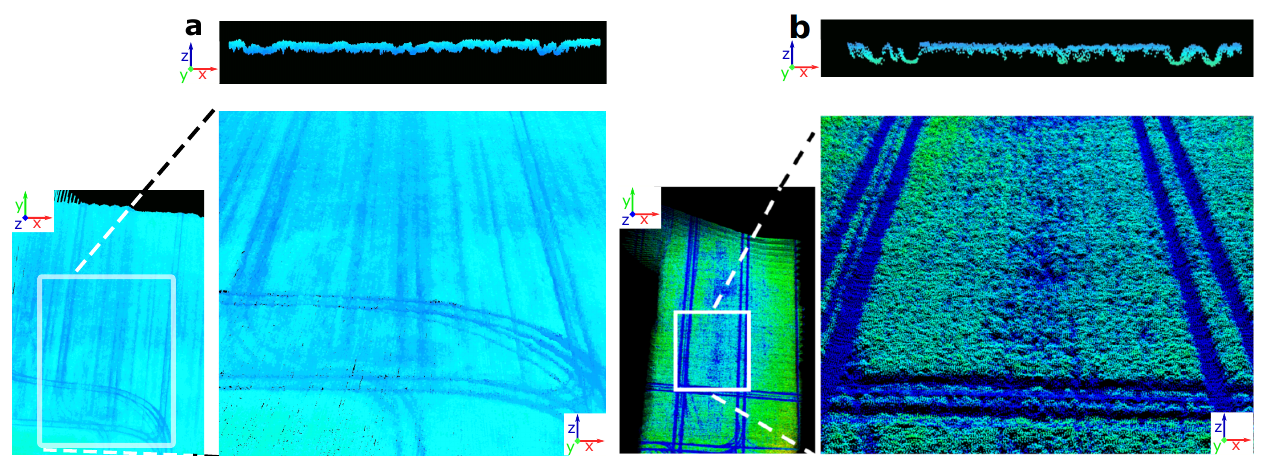
Figure 5. The point cloud data (PCD) scenes (the crops are shown at the maturity stage and the PCD scenes are colored by elevation): ( a ) the barley field in 2020; ( b ) the wheat field in 2021. In both ( a , b ), the upper panels show the cross-sectional views of the PCD, with a buffer depth of 0.5 m. The x (–), y (–), and z (–) axes indicate easting, northing, and elevation, respectively. It can be seen that there was a higher PCD porosity in ( b ) than in ( a